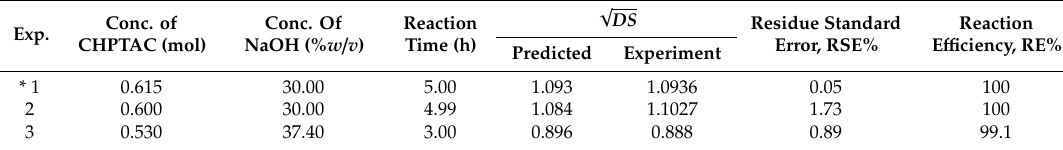
Table 3. Predicted and observed response values conducted at an optimum